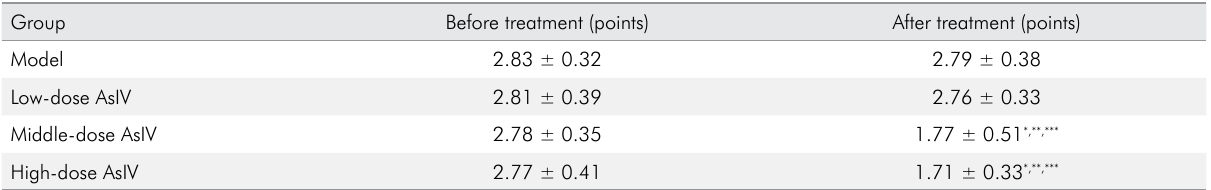
Table 1. Tooth mobility scores in different groups before and after treatment. Group Before treatment (points) After treatment (points)